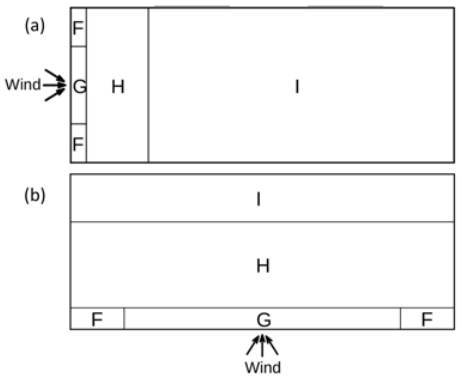
Figure 6. Distribution of the pressure coefficients for a flat roof with (a) wind direction on the short side and (b) wind direction on the long